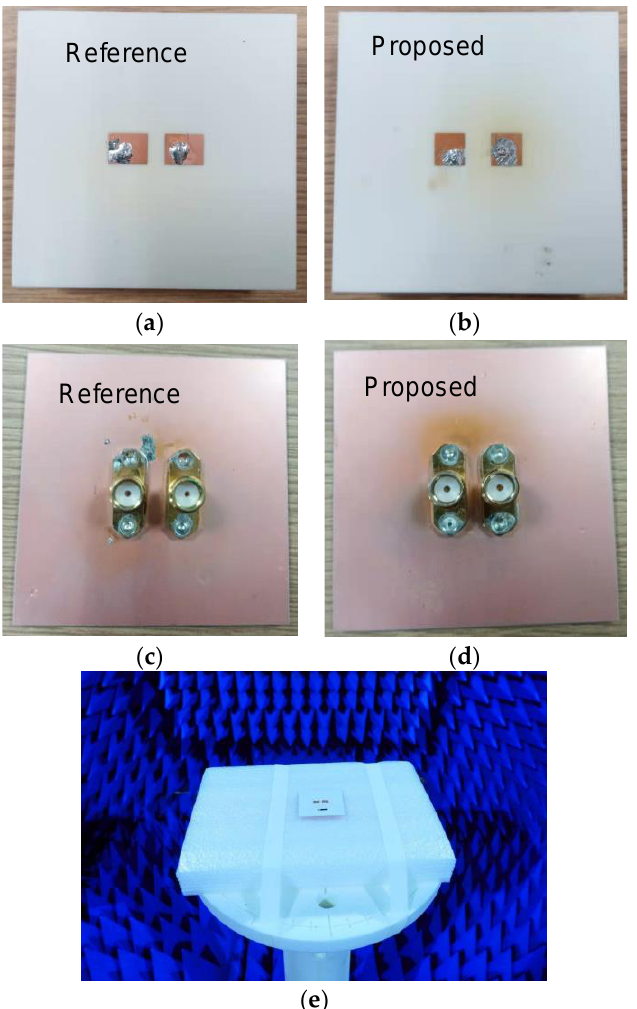
Figure 6. Photographs of fabricated arrays. ( a , b ): Front view. ( c , d ): Back view. ( e ) Measurement setup in an antenna chamber. Table 1. Dimensions of fabricated antennas. (Unit: mm).